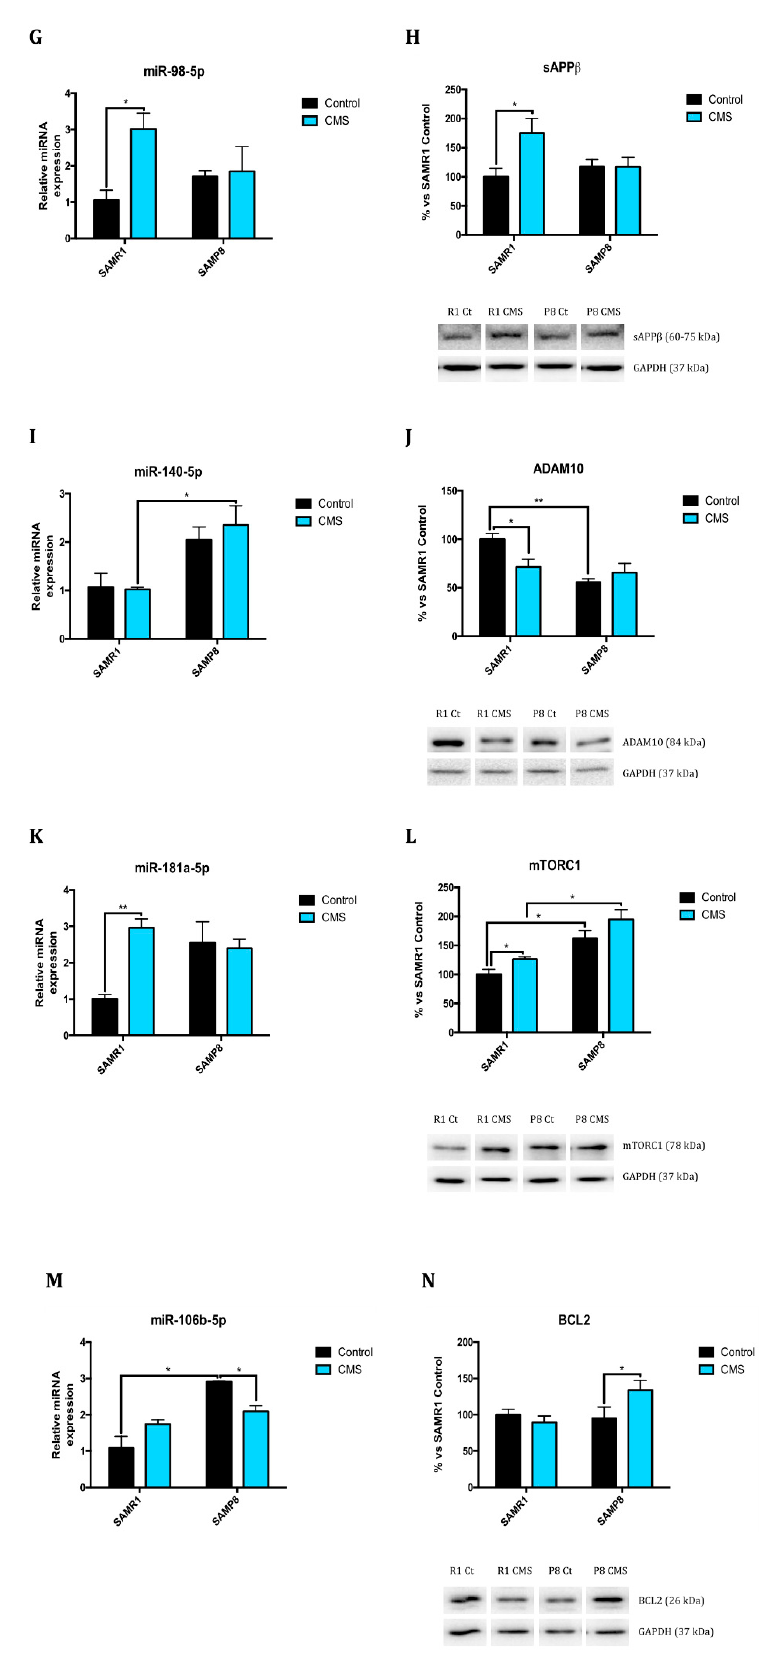
Figure 2. Validation of a representative subset of miRNA involved in brain aging,